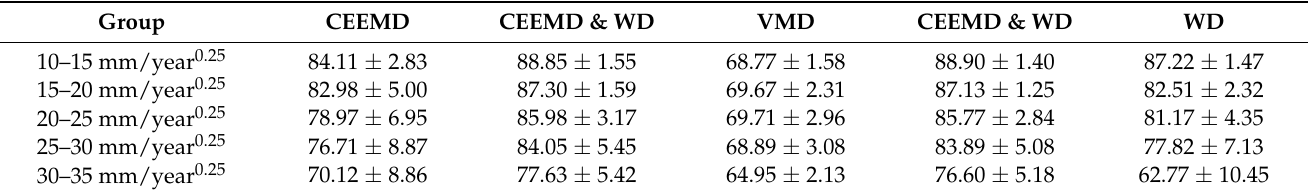
Table 1. The averages of CRs of flicker noise for different methods with five groups. (Unit: %). Group